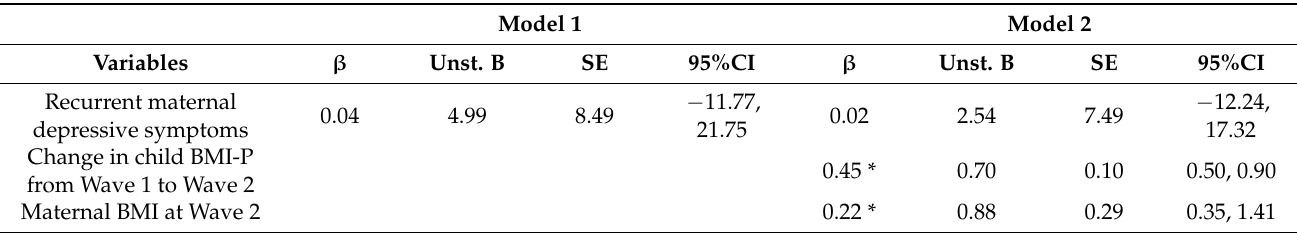
Table 2. Linear regression analysis of the association between recurrent maternal depressive symptoms from Wave 1 and Wave 2 and child BMI percentile at Wave 2.